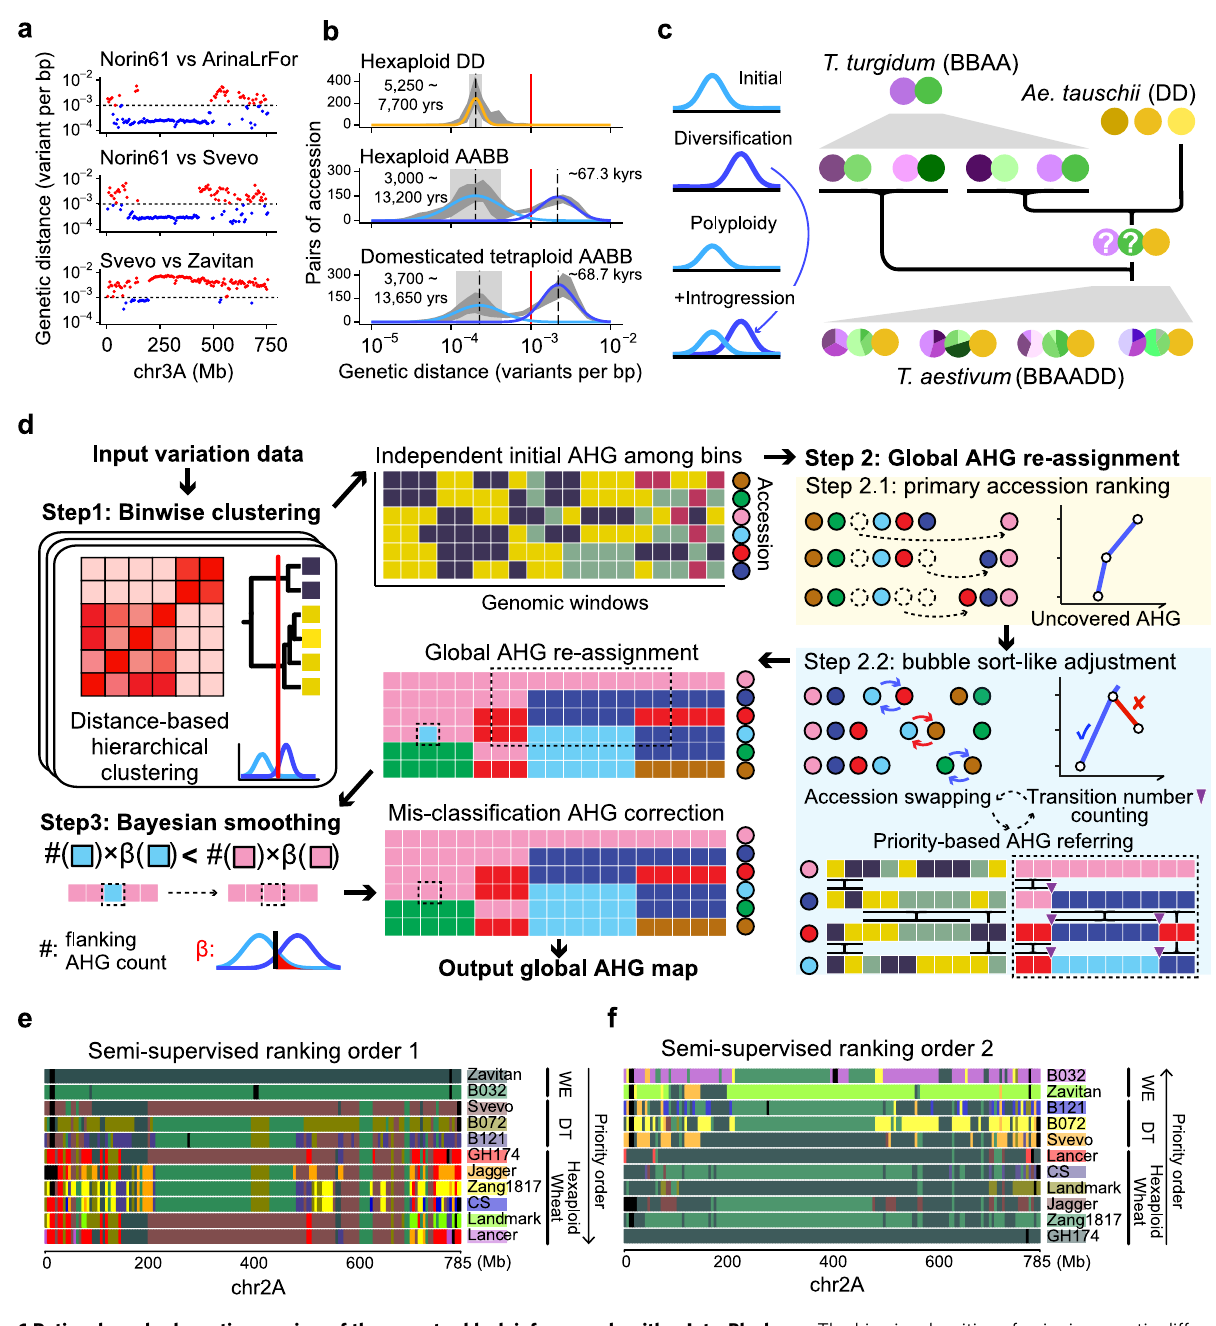
Fig. 1 Rationale and schematic overview of the ancestry block inference algorithm IntroBlocker. a The binwise densities of pairwise genetic differences along chromosome 3A for the three accession pairs: (1) hexaploid wheat cultivars Norin61 versus ArinaLrFor, (2) Norin61 versus tetraploid durum wheat Svevo, (3) Svevo versus tetraploid wild emmer wheat Zavitan. Each point represents a 5 Mbp genomic window. b Distribution of pairwise genetic distances for the D subgenome of hexaploid wheat (upper), and the A&B subgenomes in hexaploid wheat (middle) and in domesticated tetraploid wheat (bottom). Shadow ribbons, mean±sd. Solid lines represent the Gaussian distributions fi tted by the EM algorithm from 1000 randomly chosen sample pairs in each track. Mean±sd of the fi tted Gaussian distribution are indicated by dashed lines and shadow boxes, with corresponding divergence times labeled. Red line, the threshold at 10 − 3 variant per bp. c A model for strati fi ed variant density in the A&B subgenomes. The interploidy introgression from highly diversi fi ed tetraploid wheat (BBAA) introduced high-diversity blocks to hybridized hexaploid wheat (BBAADD), leading to bimodal distribution in A&B subgenomes and unimodal distribution in the D subgenome. d Schematic overview of the IntroBlocker algorithm. Step 1, for each 5 Mbp window, the samples hierarchically clustered by genetic distance were grouped with a cut-off at the threshold (10 − 3 variants per bp) imputed from a bimodal distribution. Step 2, AHGs were re-assigned globally using an accession priority-based referring strategy to minimize the transition number, where the priority order was determined by a bubble sort-like method. Step 3, a Bayesian approach was introduced for smoothing noisy signals by correcting misassigned blocks based on AHG types of neighboring windows. e , f Two colored mosaic graphs of AHGs in chromosome 2 A across 11 selected samples under a semi-supervised mode with different priority orders, WE> DT > HW ( e ) and HW > DT > WE ( f ). For each window, the same color indicates the same AHG and black indicates CNV block. The sample-dominated colors are marked under accession-IDs. WE, wild emmer wheat. DT, domesticated tetraploid wheat. HW, hexaploid wheat. Source data are provided as a Source Data fi